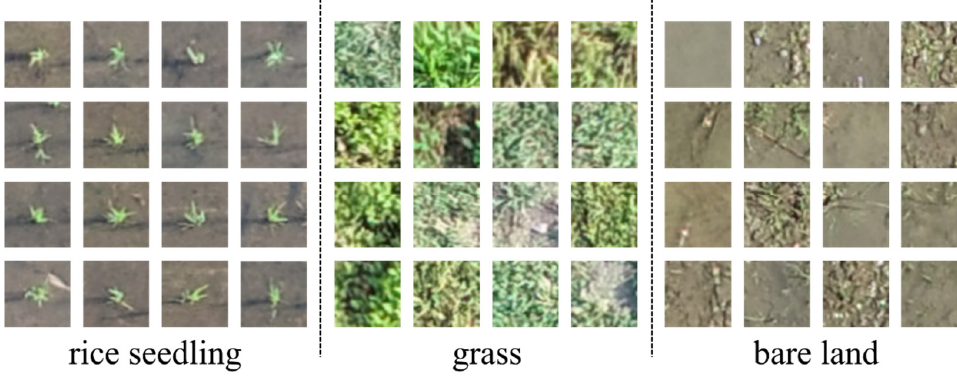
Figure 5. Examples of annotated images for model training.